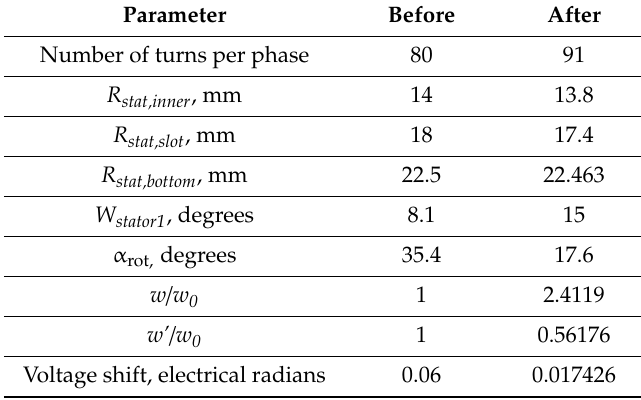
Table 3. The FRM parameters varied during the optimization. Additionally, R stat,middle = 0.5 · ( R stat,slot + R stat,inner ).